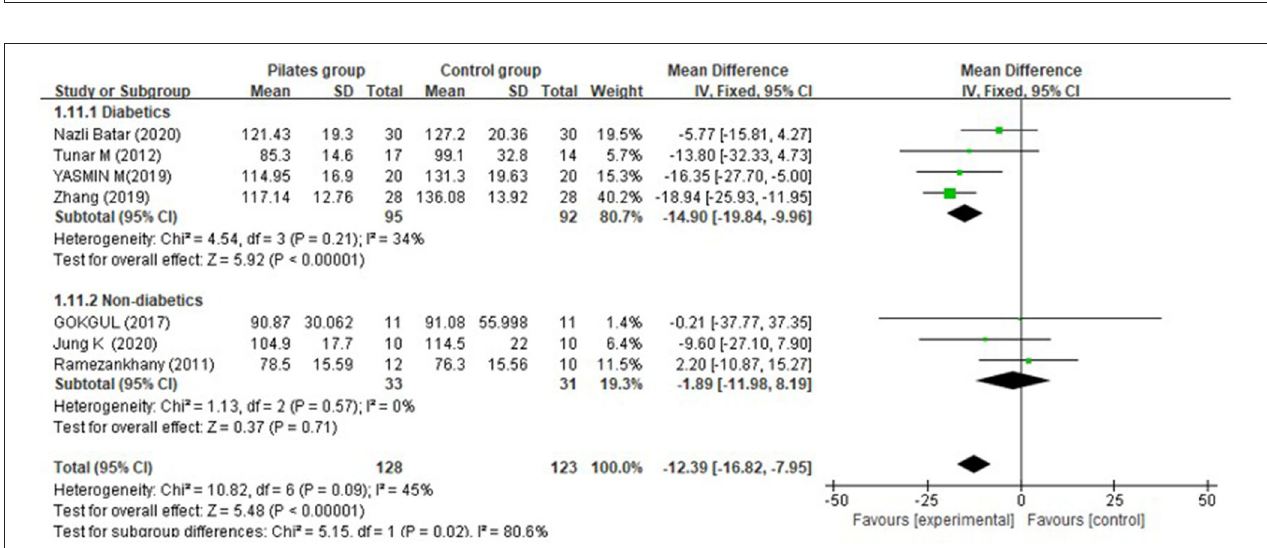
FIGURE 9 | Meta-analysis and forest plot for high-density lipoprotein cholesterol.